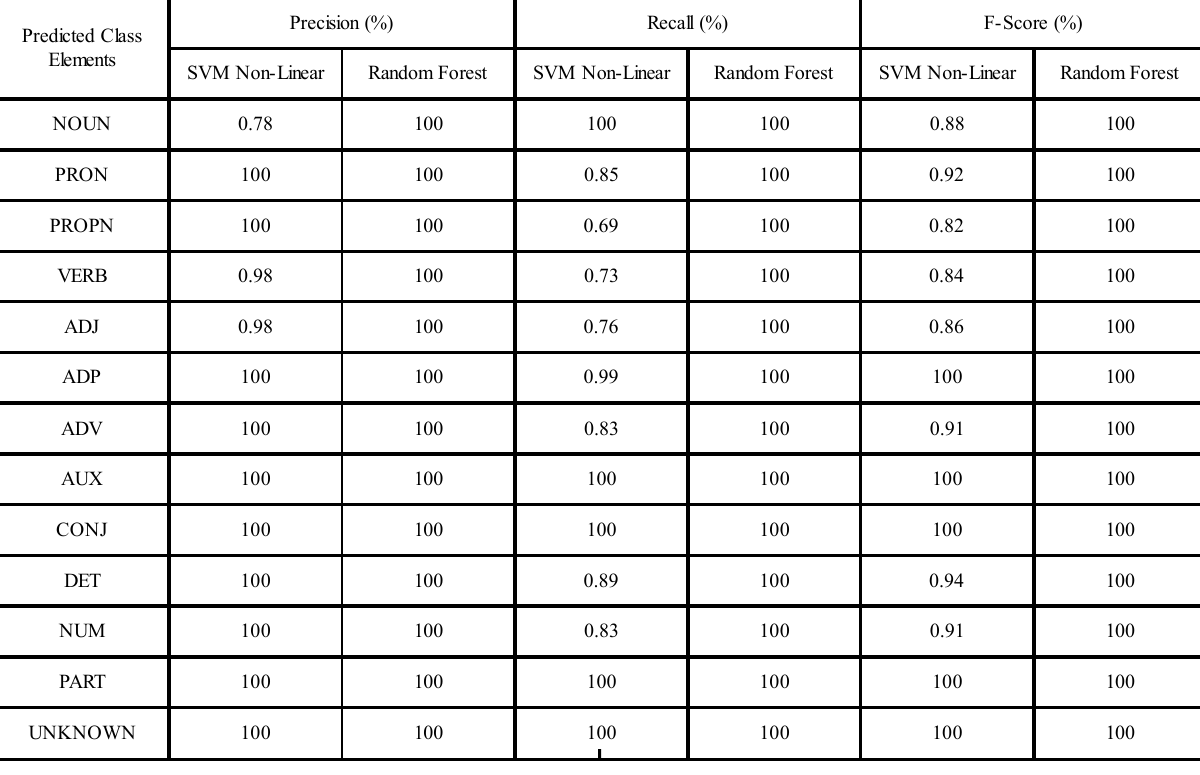
TABLE 7. COMPARISON OF PRECISION, RECALL AND F-SCORE TARGETING CLASS